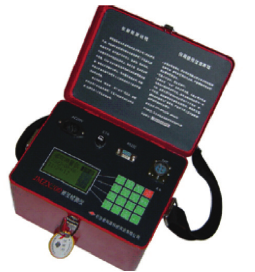
Figure 4: JMZX200X comprehensive tester.